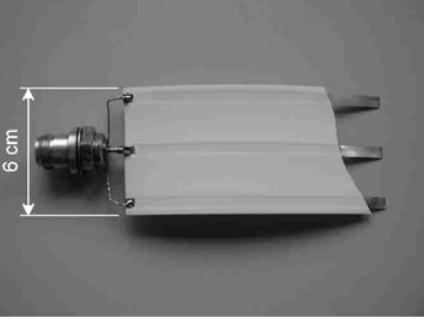
Figure 3. The PE-insulated flat band cable of the TAUPE-TDR sensor. (short section with uncovered conductor to show connection and geometry)